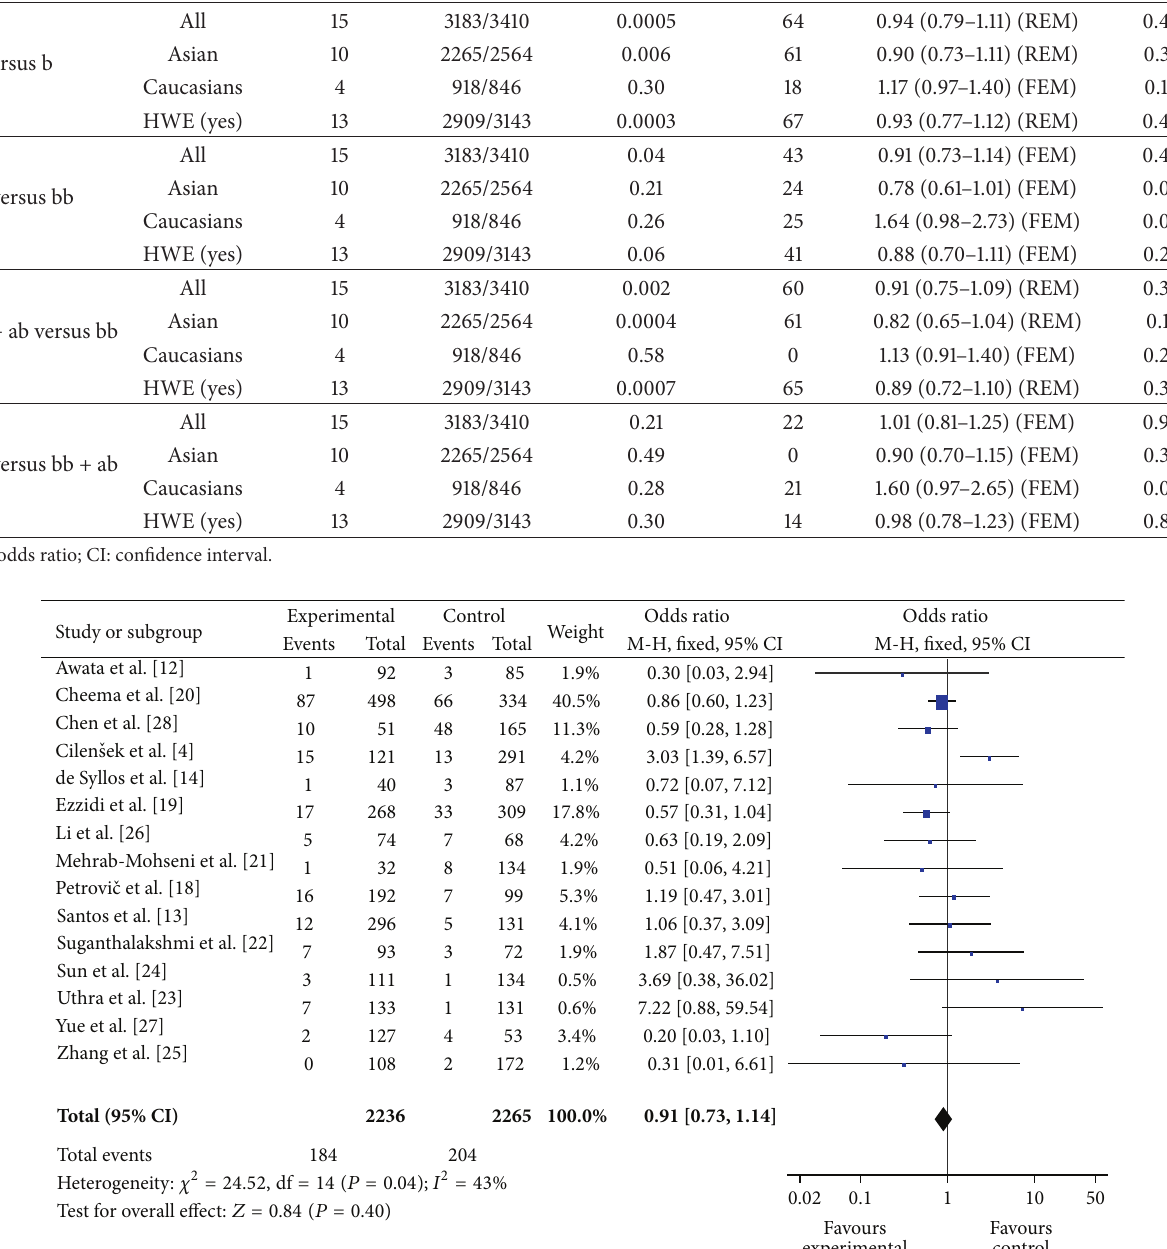
Table 3: Meta analysis of the association of eNOS-4b/a gene polymorphism with DR in type 2 diabetes. Genetic model